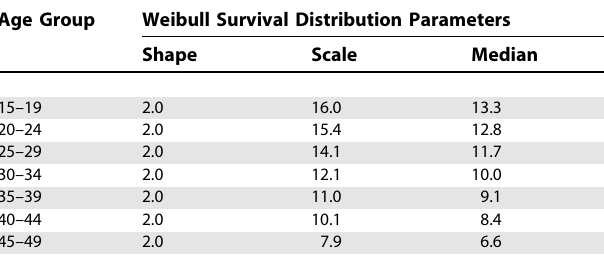
Table 2. Parametric Model Estimates of Survival after Infection in Southern and Eastern Africa